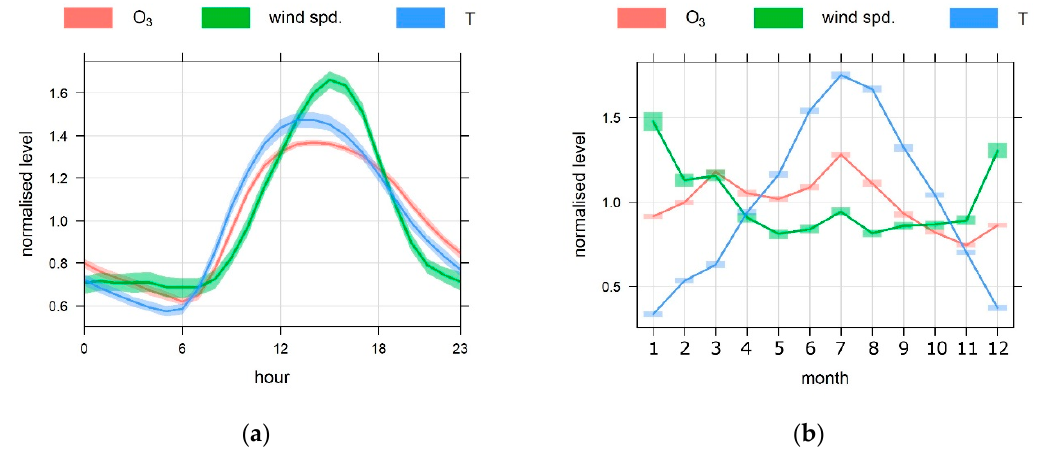
Figure 5. ( a ) Diurnal and ( b ) monthly profile of ozone (O 3 ), wind speed (ws) and temperature (T). Normalized levels are achieved by dividing the values of each variable by its mean value. Also shown on the plots is the 95% confidence interval in the mean.